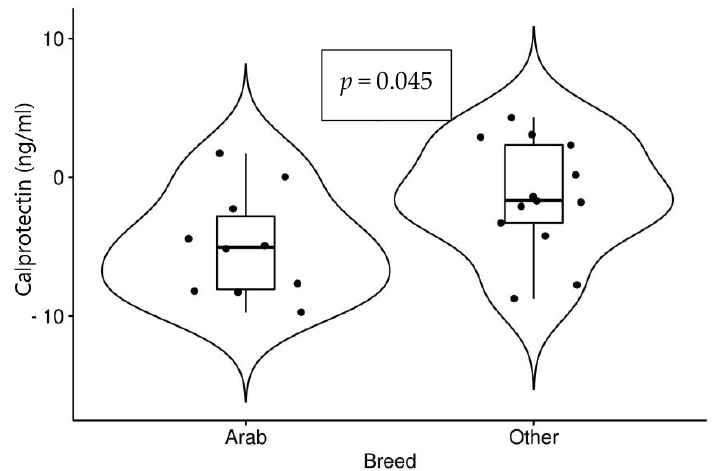
Figure 2. Changes in values of calprotectin (after races − before races) in 10 Arabian horses and 13 horses of other breeds.